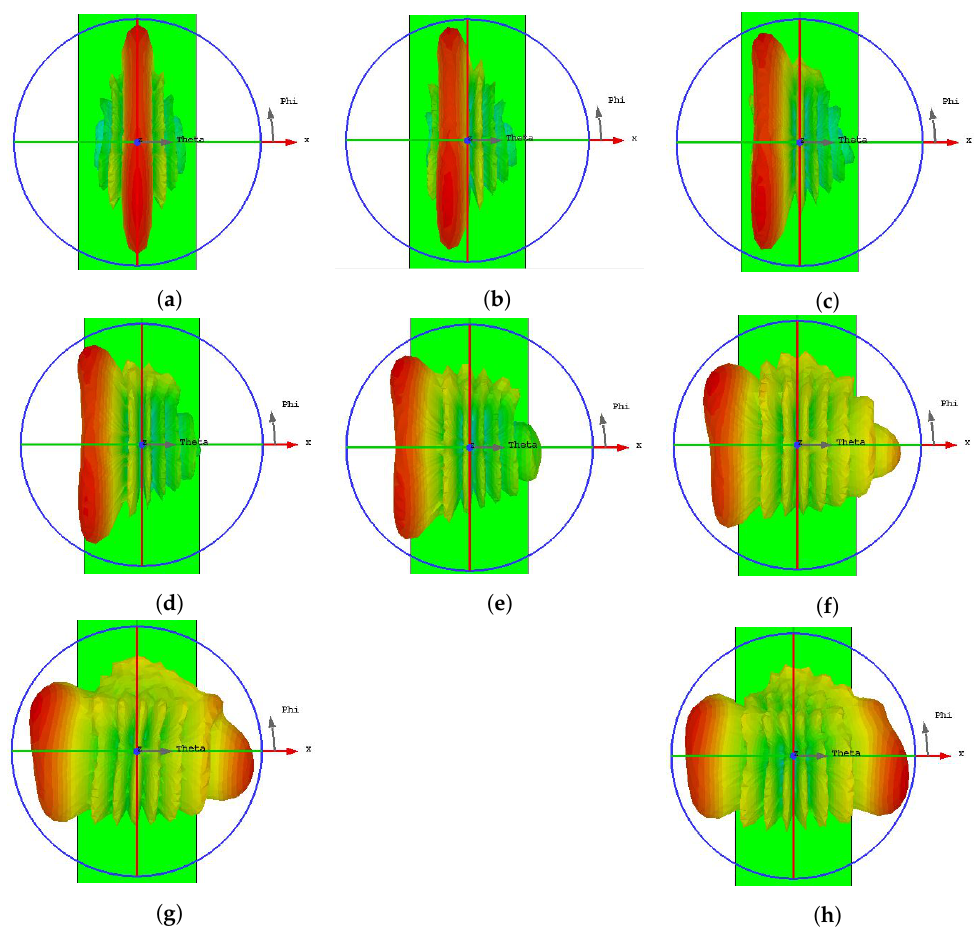
Figure 12. 3D beam scanning of the proposed MIMO array at ( a ) 0°, ( b ) 10°, ( c ) 20°, ( d ) 30°, ( e )